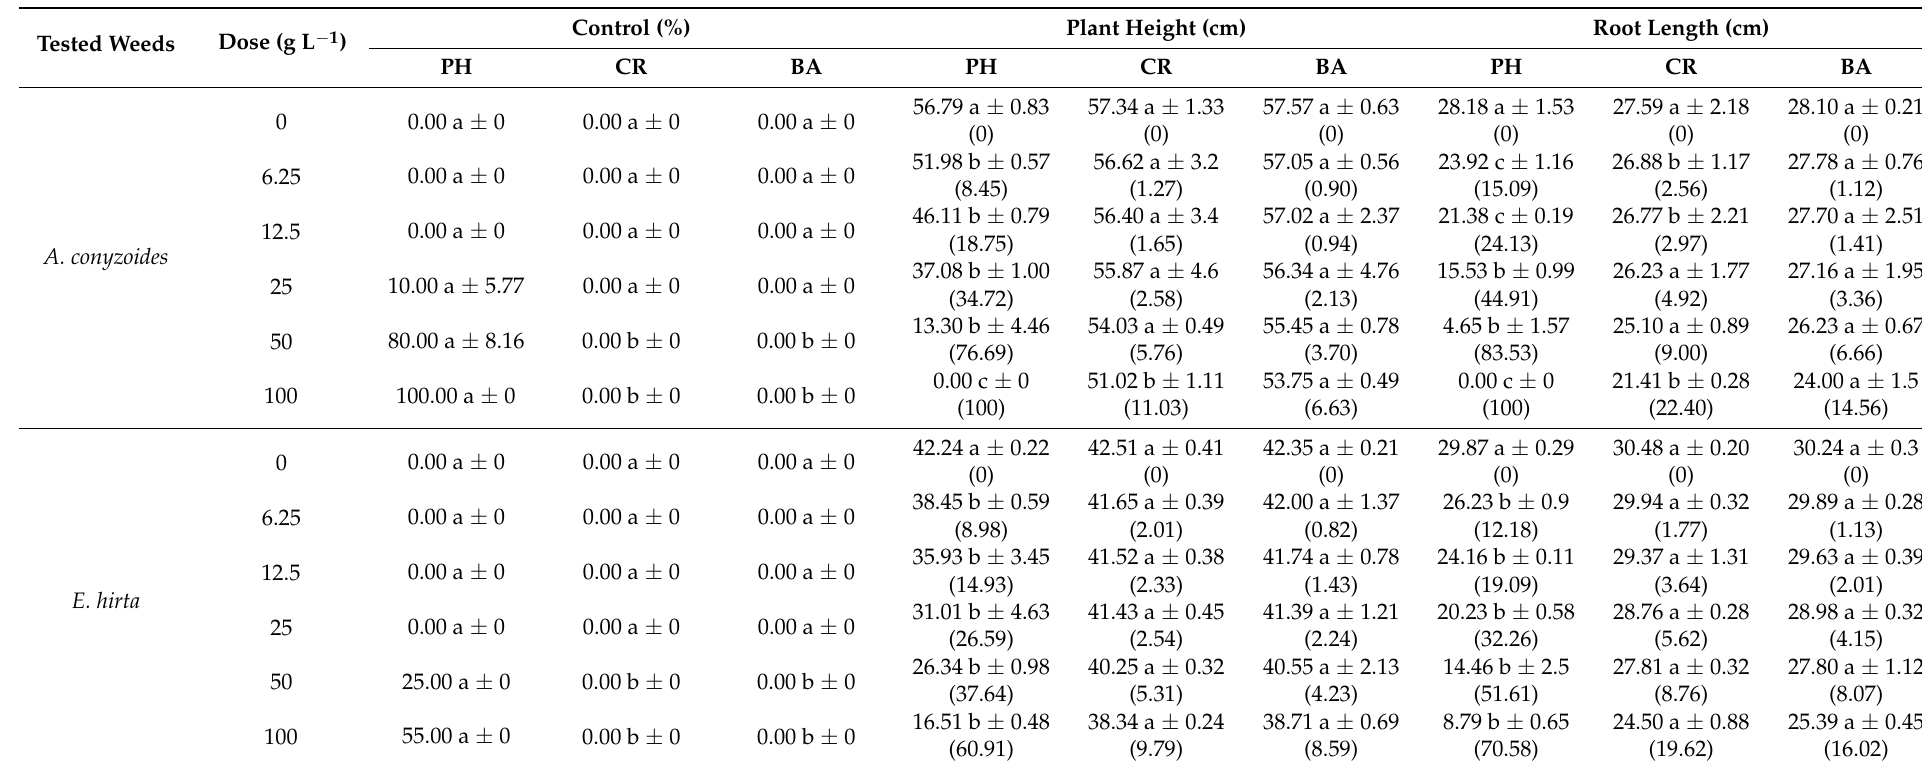
Table 4. Effect of methanol extract of P. hysterophorus , C. rutidosperma , and B. alata on the control (%), plant height (cm) and root length (cm) of A. conyzoides , E. hirta , weedy rice, and E. colona